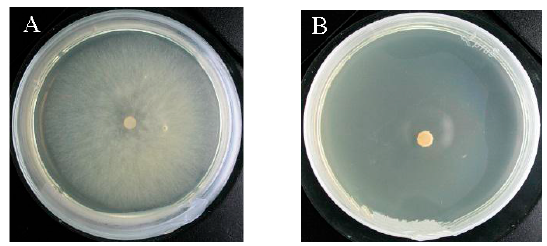
Figure 5. Inhibitory effect of 95% ethanol ( A ) and tobacco cembranoids extract ( B ) on V. mali . Table 1. Virulence of tobacco cembranoids extract against the hyphal growth of V. mali . Treatment Regression Equation